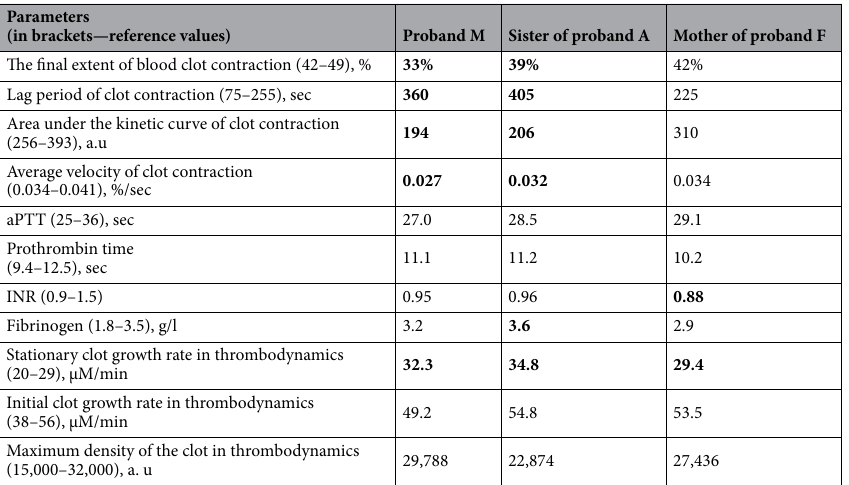
Parameters (in brackets—reference values) Proband M Sister of proband A Mother of proband F The final extent of blood clot contraction (42–49), % 33% 39% 42% Lag period of clot contraction (75–255), sec 360 405